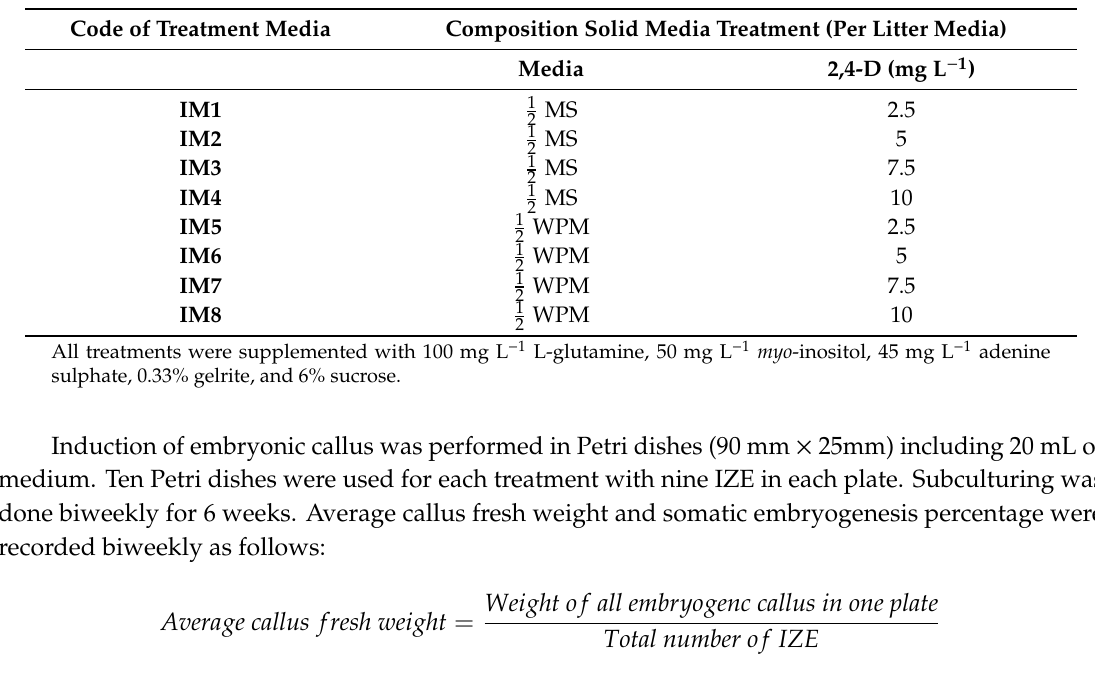
Table 8. The treatments composition during the induction